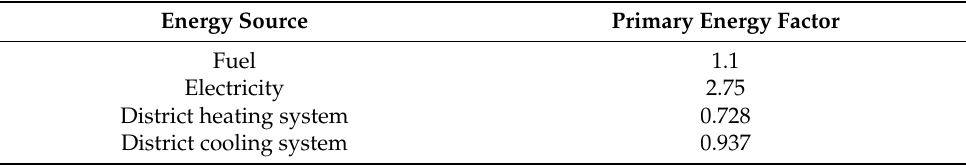
Table 6. Primary energy factor depending on energy source based on Building Energy Efficiency Certification.